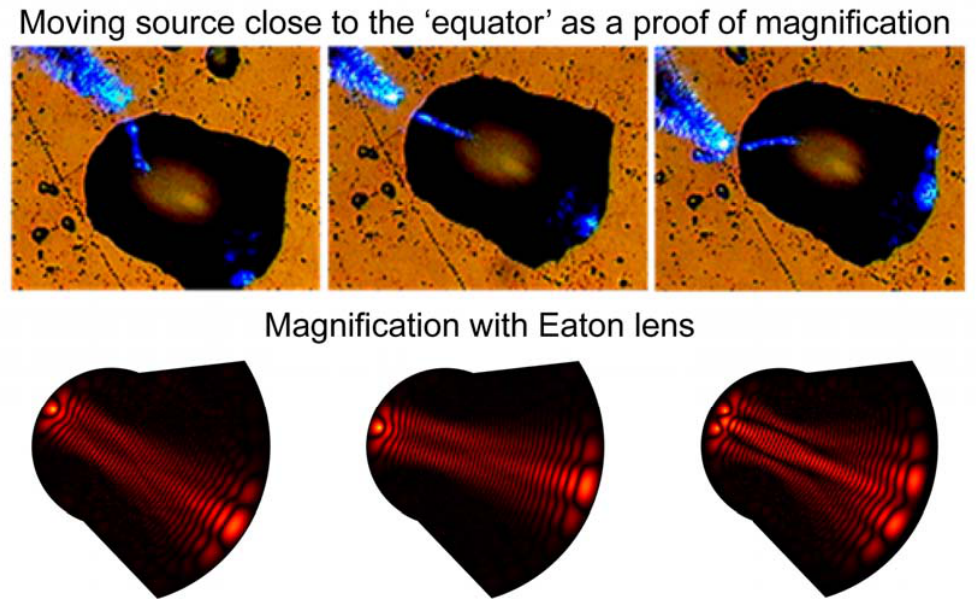
Figure 12. Experimental testing of image magnification of the “deformed droplet”. The NSOM probe tip was moved along the droplet edge. Bottom row presents results of our numerical simulations in the case of one and two point sources. The shape of the “deformed droplet” used in numerical simulations closely resembles the shape of the actual droplet.